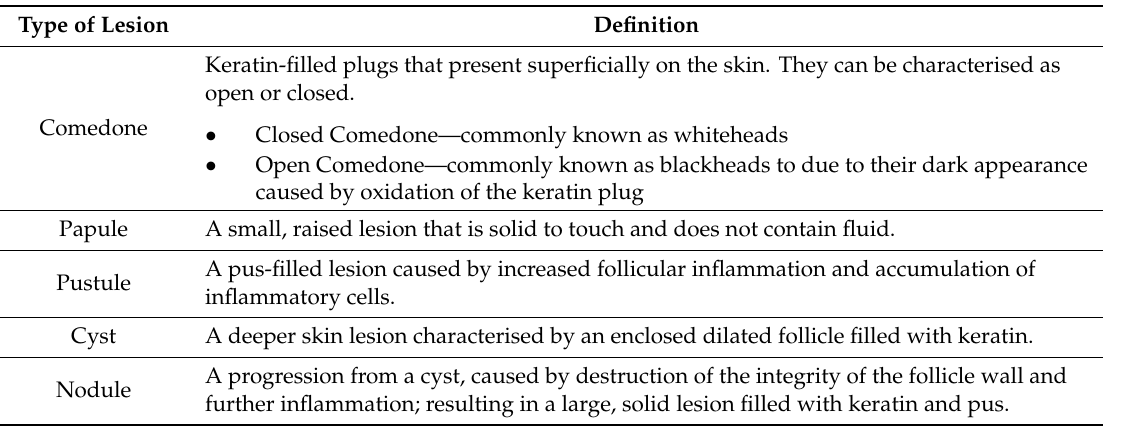
Table 1. Definitions of lesions associated with Acne vulgaris [2].